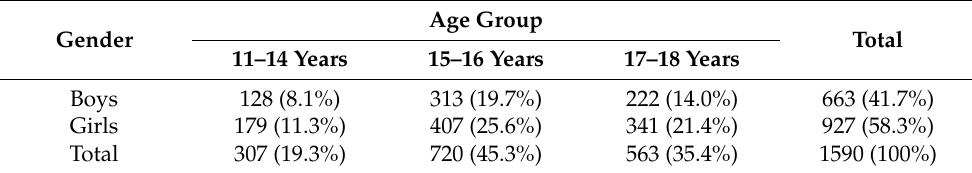
Table 1. Distribution, n (%), of the sample, by gender and three age groups.